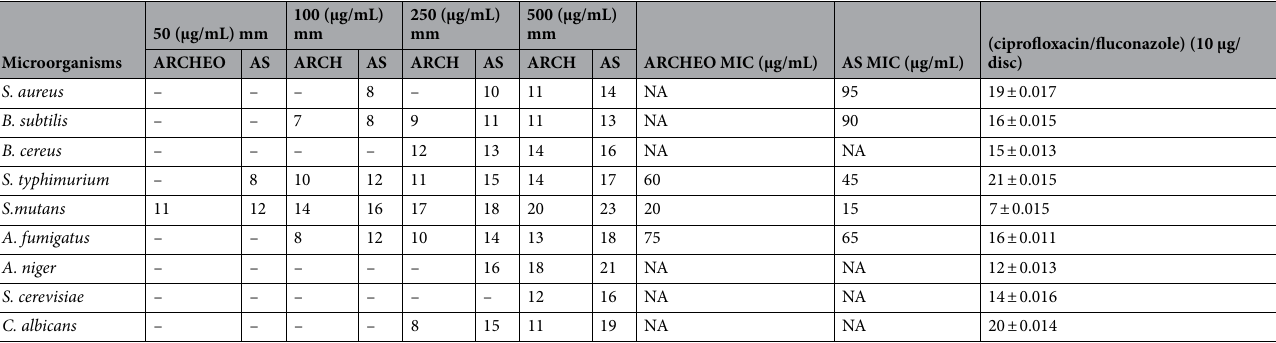
Table 5. Zone of inhibitons and minimal inhibitory concentration (MIC) for ARCHEO and anethole standard against different bacterial and fungal strains. ARCHEO anethole rich C. heptaphylla essential oil, AS anethole standard, NA not applicable.